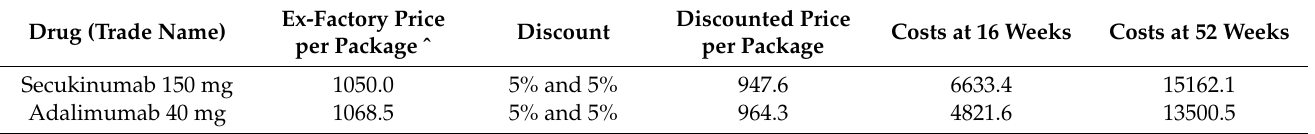
Table 3. Costs of secukinumab and adalimumab (in